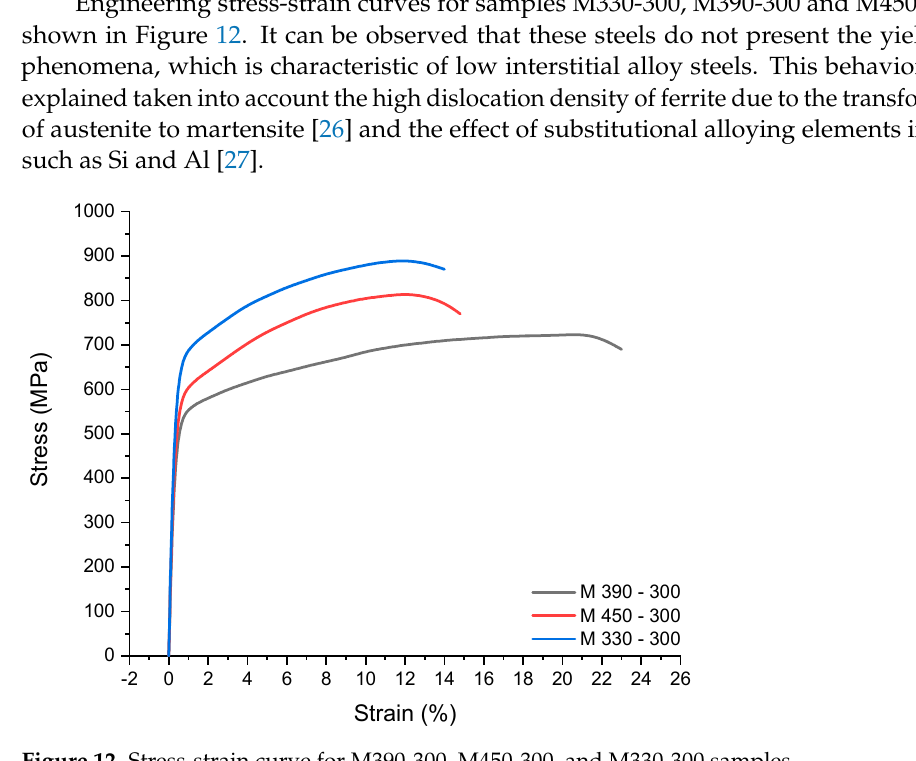
Figure 12. Stress-strain curve for M390-300, M450-300, and M330-300